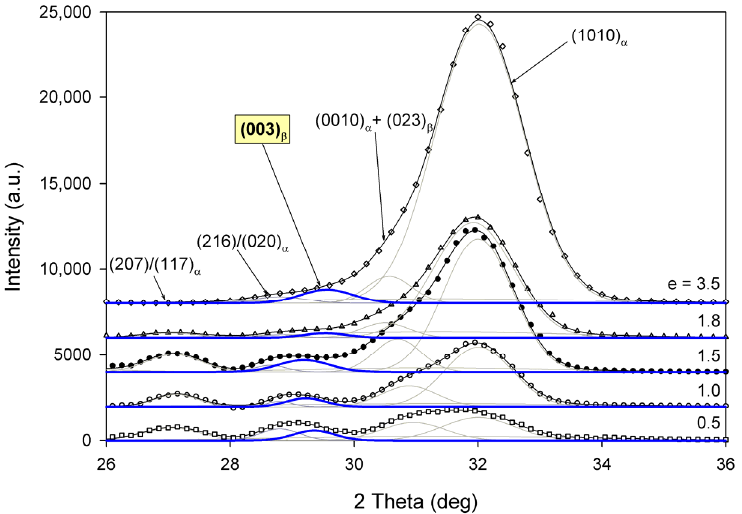
Figure 16. WAXS meridional scans of the 2D-WAXS patterns of samples deformed at T d = 140 °C to indicated strains. The experimental curves (black symbols) are compared with the ‘best fit’ curves (black lines) and their peak components (gray lines). The (003) β peak is drawn with thick blue line.